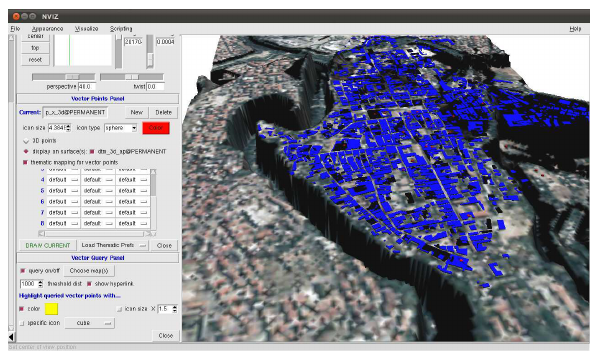
Figure 15. DTM with building and vector points (red)